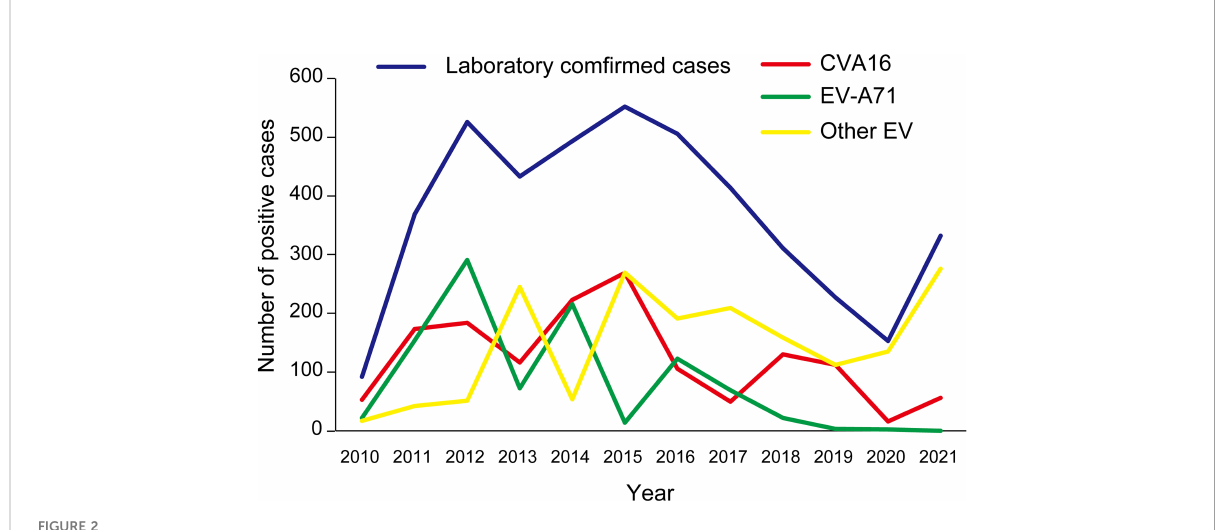
FIGURE 2 Genotype of viruses causing hand, foot, and mouth disease during 2010 – 2021 in Taiyuan.